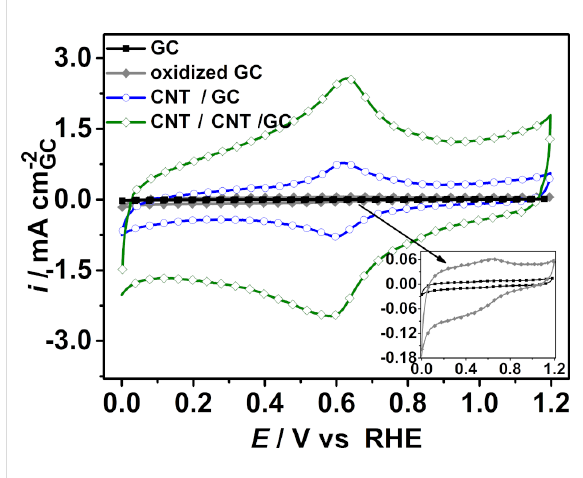
Figure 7: Cyclic voltammograms of GC, oxidized GC, CNT/GC and CNT/CNT/GC recorded at a scan rate of 100 mV s − 1 in N 2 -saturated 0.5 M H 2 SO 4 aqueous electrolyte solution at room temperature.